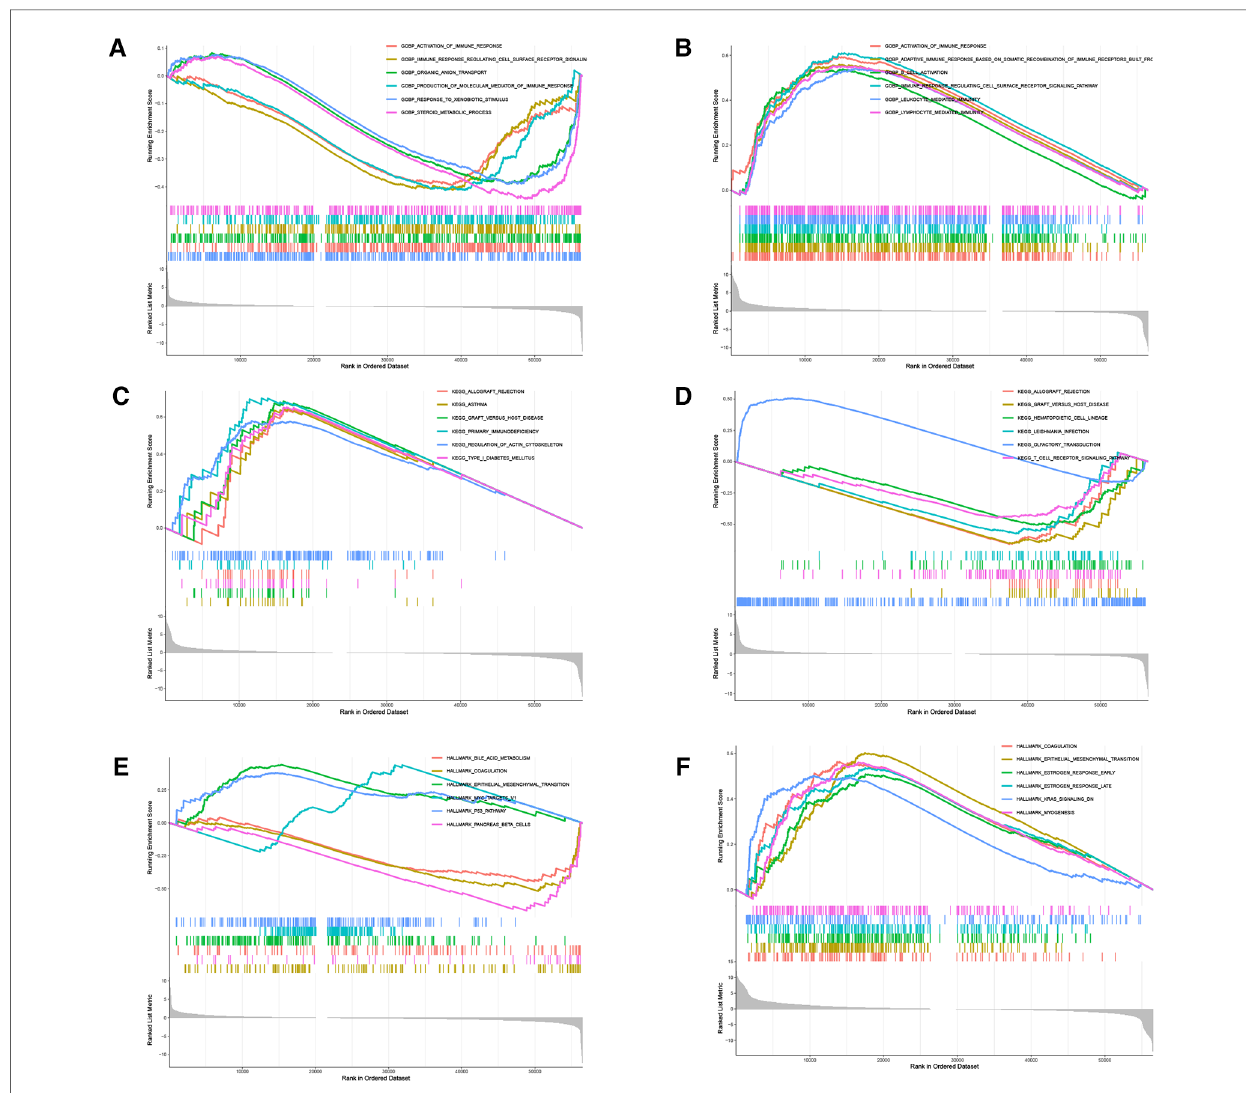
FIGURE 13 GSEA. Analysis of RBP1 enrichment in BP ( A – B ), KEGG( C – D ), and Hallmark ( E – F